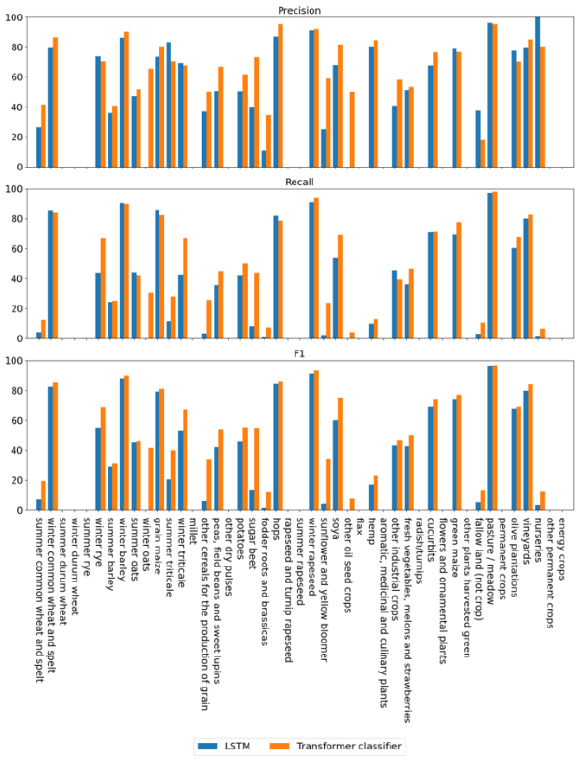
Figure 6. Class-specific scores (precision, recall, F1) obtained using an MLP encoder (blue) and a Transformer encoder (orange).